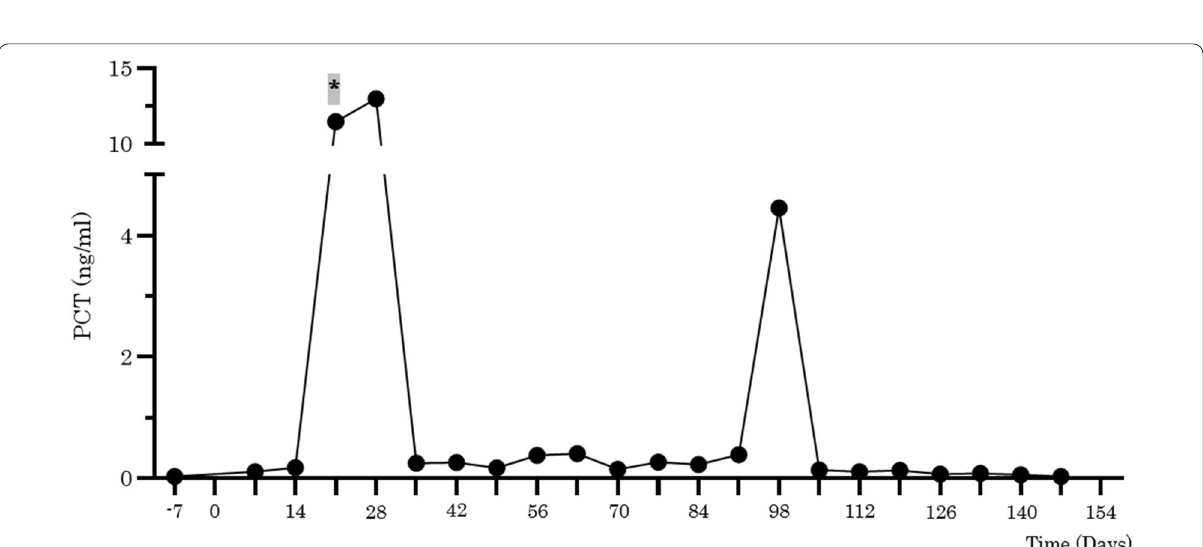
Fig. 6 The change of serum procalcitonin value in case 2 during the perioperative period. A bold asterisk highlighted in gray indicates positive blood culture of Clostridium butyricum . PCT,